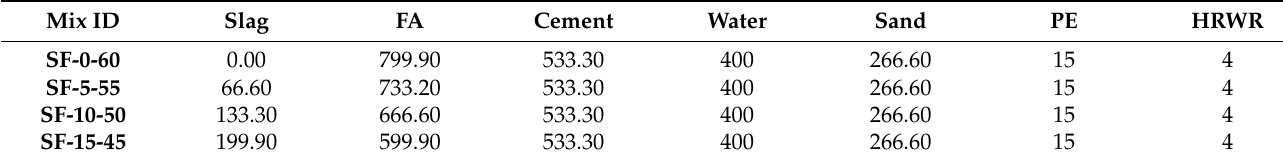
Table 1. Mix proportions of ECCs (kg/m 3 ).